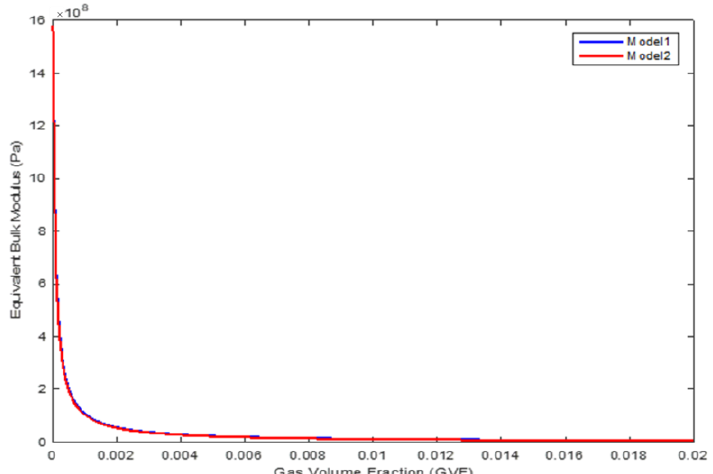
Figure 12. Equivalent fluid bulk modulus.